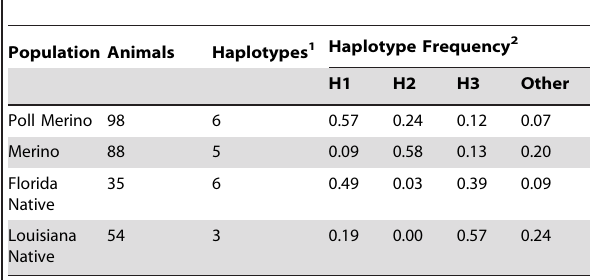
Table 3. Haplotype frequencies at the Poll locus on sheep chromosome